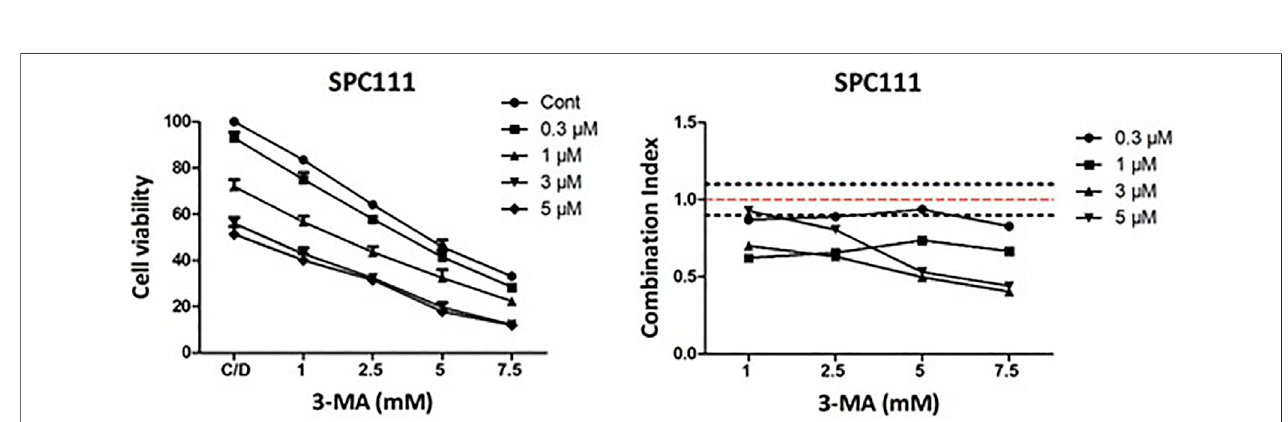
FIGURE 9 | Combination treatment with nintedanib and autophagy inhibitor 3-MA has a synergistic effect in SPC111 cells. Cells were treated with 0.3, 1, 3, 5 μ M nintedanib and 1 mM, 2.5 mM, 5 mM, 7.5 mM 3-MA in all combinations for 72 h and cell viability was analyzed with SRB assay. Combination index (CI) was calculated for each combination and that indicated synergism (CI < 0.9), additive effect (CI is between 0.9 and 1.1) or antagonism (CI > 1.1). Dotted lines indicate these cut-offs.